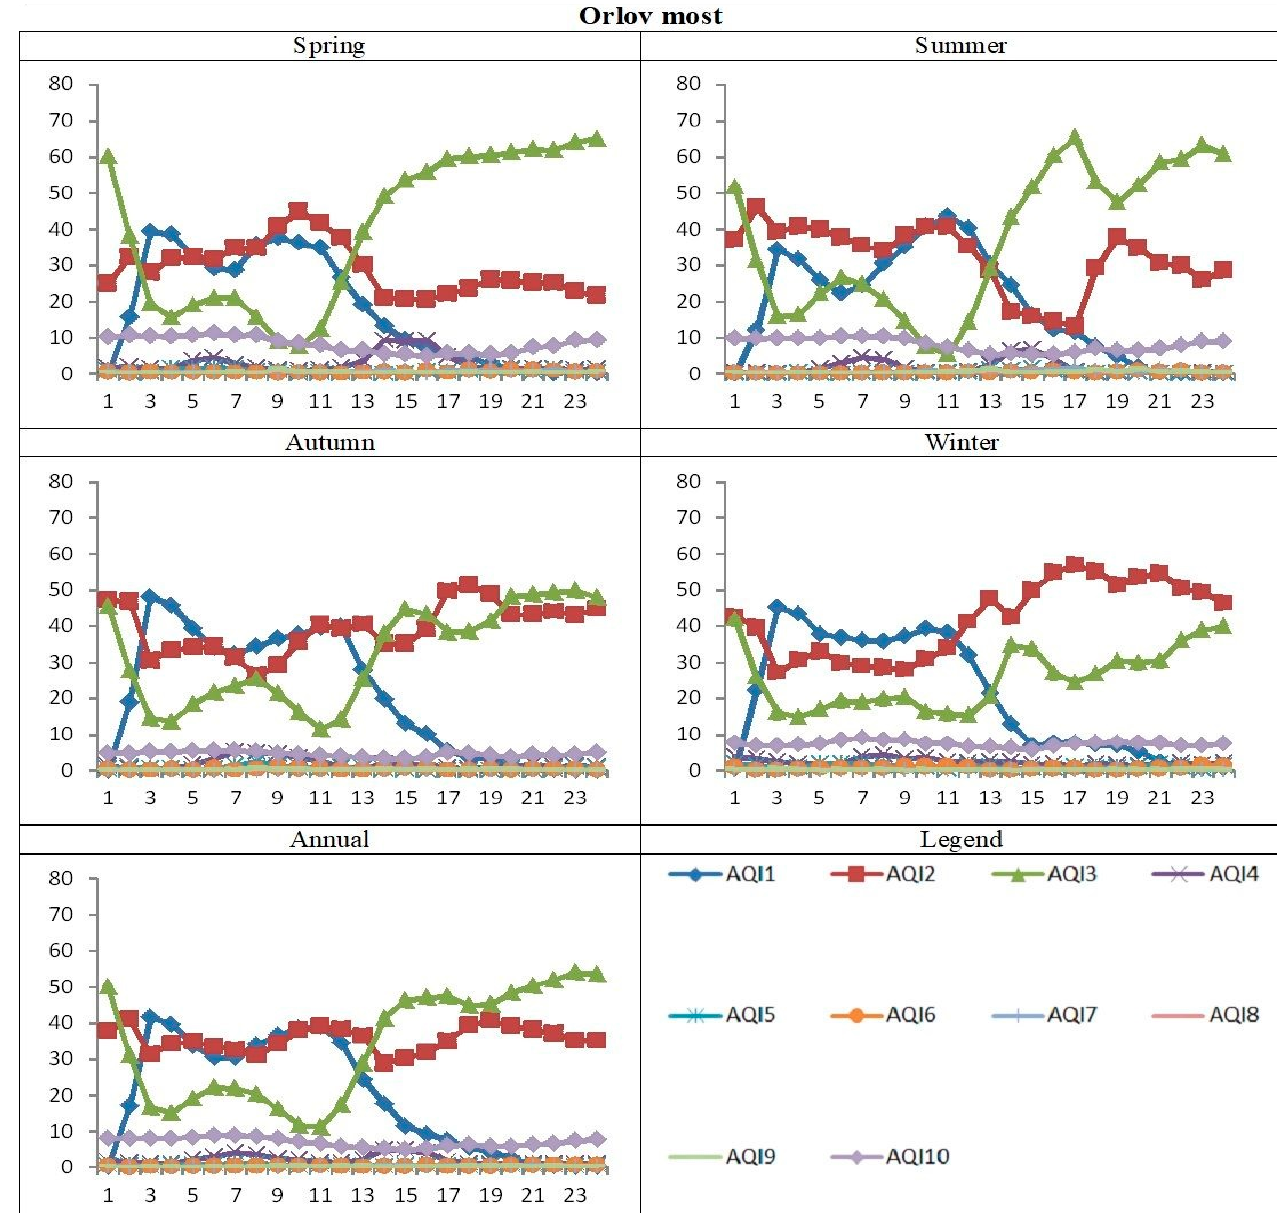
Figure 4. Average recurrence (in %) of the different indices (from 1 to 10) for the Orlov Most (Sofia). Figure 5, for the Bistritsa point, shows that the indices AQI1, AQI2, and AQI3, which fall in the “Low” interval, have the greatest recurrence during the different seasons. The diurnal course of these indices is well defined. In the morning, AQI1 and AQI2 have a recurrence of about 40%, and in the afternoon, it drops to about 20% during the warm months and back distribution during the cold months. At this time, AQI3 has a minimum recurrence in the morning and a maximum in the afternoon of about 50%. AQI4 has an afternoon high of about 10% in the spring. In all the seasons, AQI10 stands out, which corresponds to the “Very High” category and, for this point, has a recurrence of about 5% in the morning in all the seasons. The diurnal and seasonal variability of the AQI is obviously due to both diurnal and seasonal changes of traffic and heating, as well as of the boundary layer dynamics (see for example